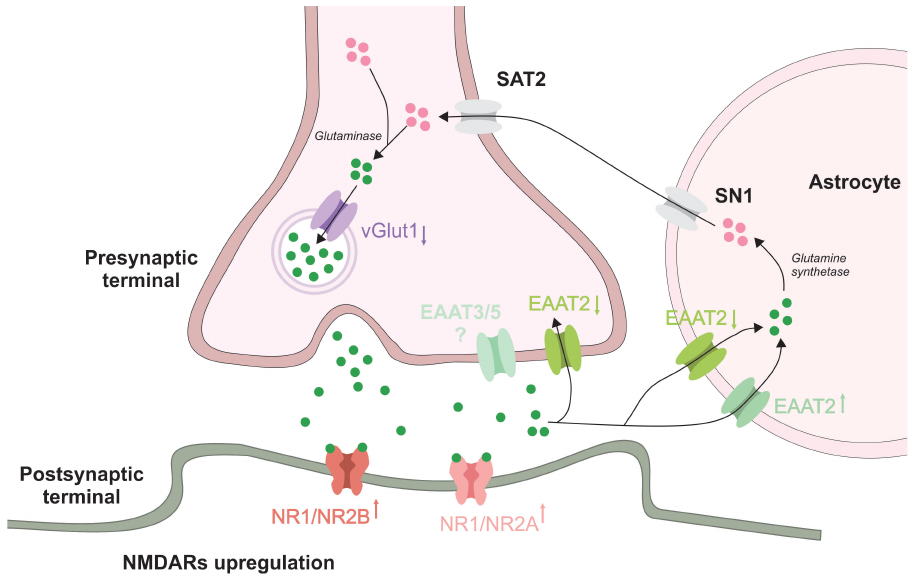
Figure 5. Proposed mechanism of effect of prolonged ALP treatment on components of glutamatergic signaling. ALP induces the increase of NMDAR subunits on post-synaptic membrane and influence the glutamate balance in the synaptic cleft trough differential modulation of EAAT1/2 in astrocytes and/or neurons and decrease of vGlut1 in pre-synaptic terminals. SN1—System N1, SAT2—System A Transporter 2, EAAT3/5—excitatory amino acid transporters